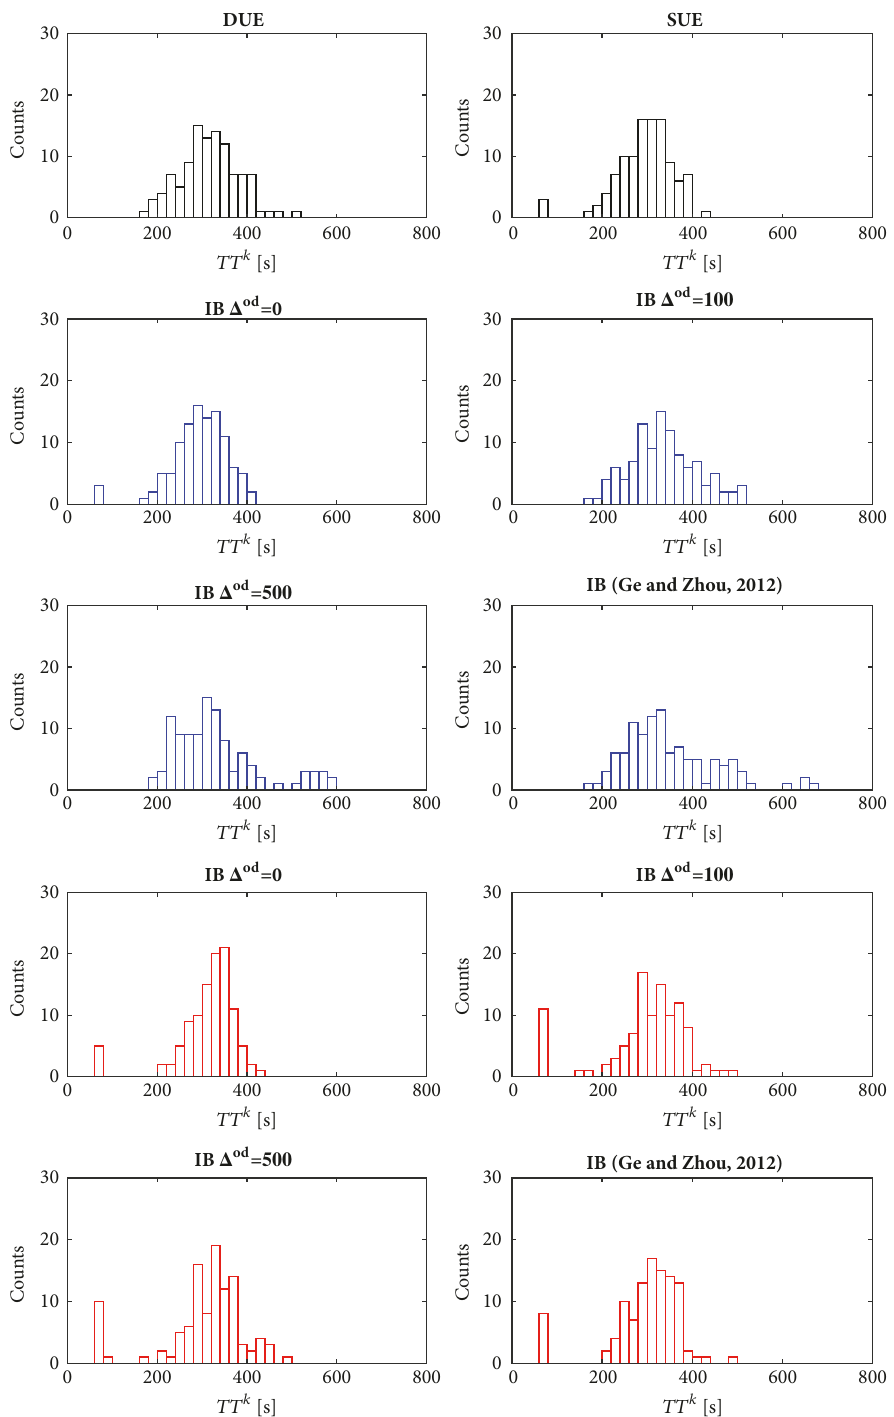
Figure 6: Average route travel time distributions for the DUE, SUE, and different settings of the indifference band.